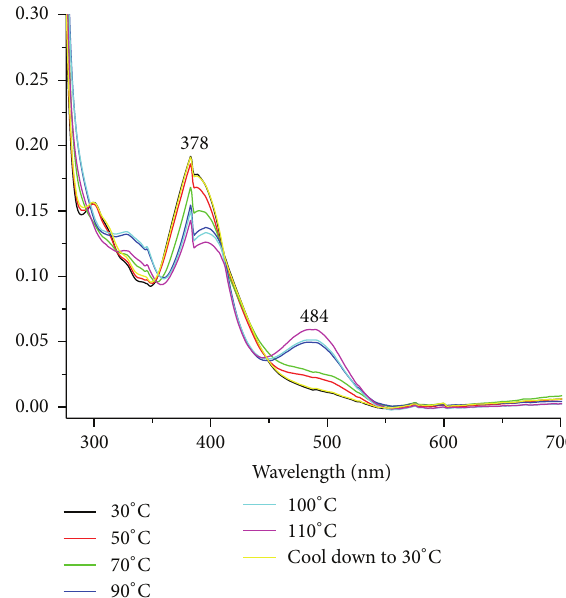
Figure 4: The UV-vis spectra of compound 2 on heating.